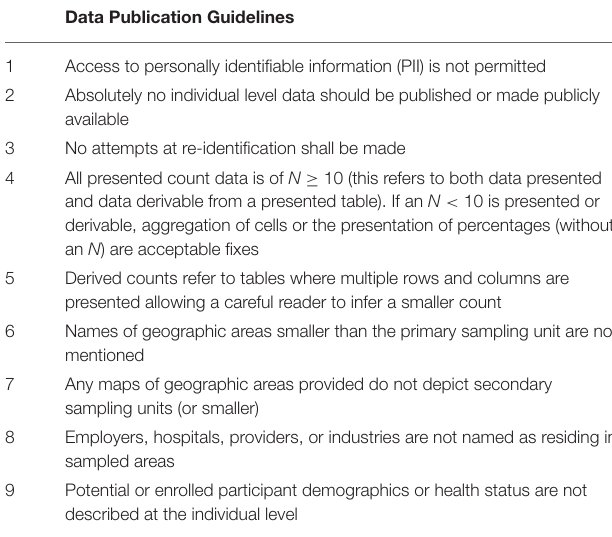
TABLE 7 | NCS archive data publication